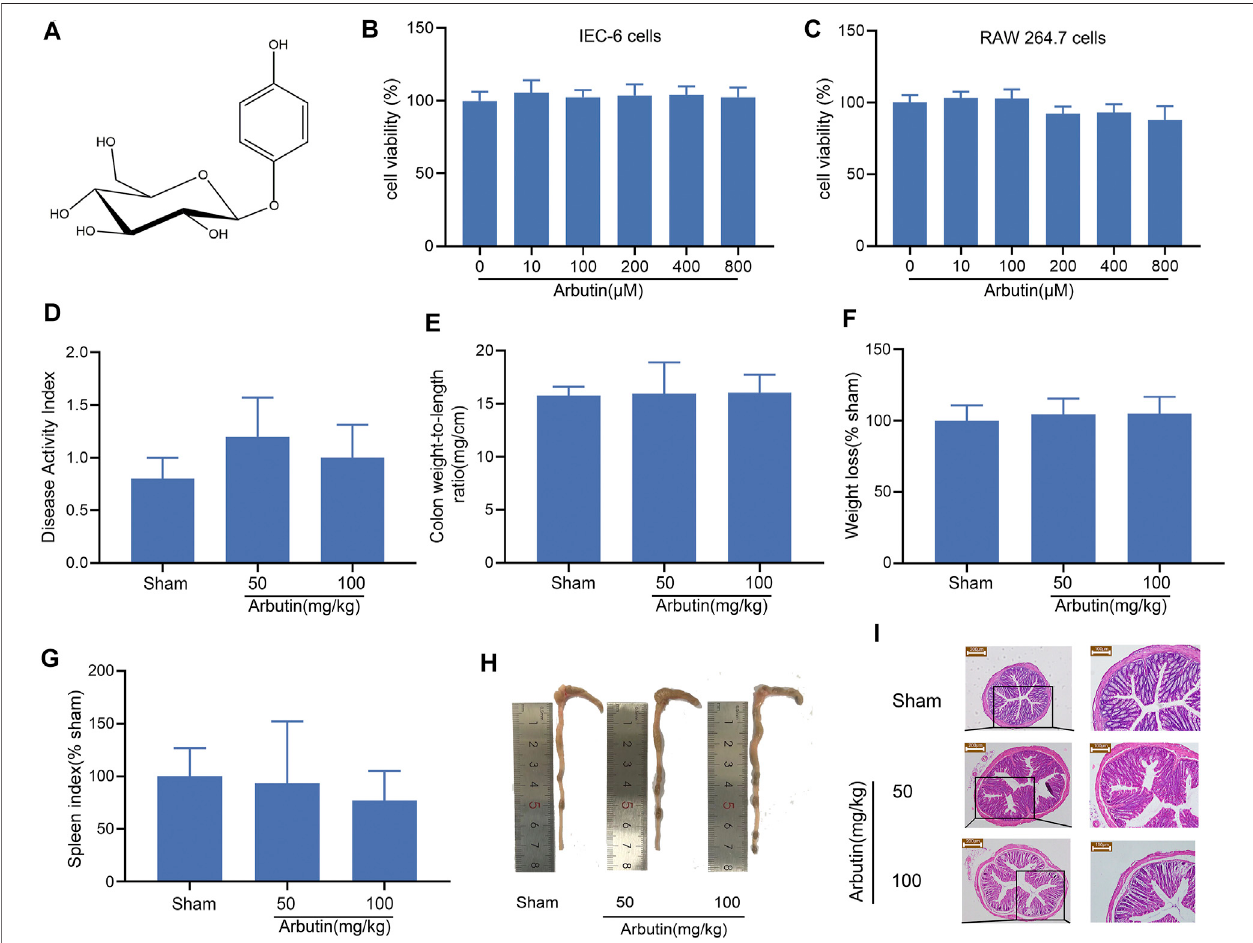
FIGURE1| Toxicologyofarbutin invitro andvivo (A) Chemicalstructureofarbutin. (B , C) IEC-6cellsandRAW-264.7cellsweretreatedwithCCK-8solutionfor4 h after pretreatment with arbutin (10, 100, 200, 400, and 800 μ M) for 24 h. The cell viability was investigated by CCK-8. The mice were given arbutin (50 and 100 mg/kg) intragastrically once a day for 7 consecutive days (D) DAI, (E) colon weight-to-length ratio, (F) body weight, (G) spleen index, and (H) macroscopic observation (I) Hematoxylin-eosinstainingofmousecolonictissue.Scalebars,200 μ m(leftpanel)and100 μ m(rightpanel).Dataareexpressedasthemean ± SD. n (cid:1) 3samples.